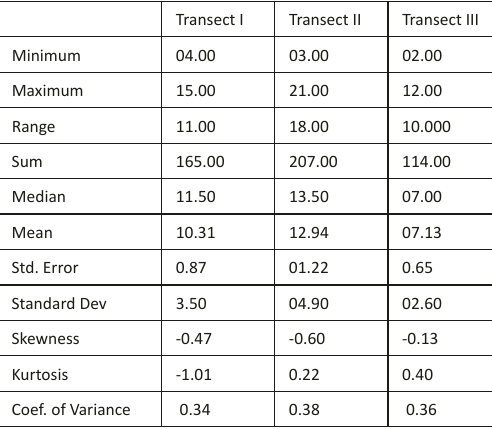
Table 2. Descriptive statistics on the variation of Sarus Crane population in the study area during September 2011 to December